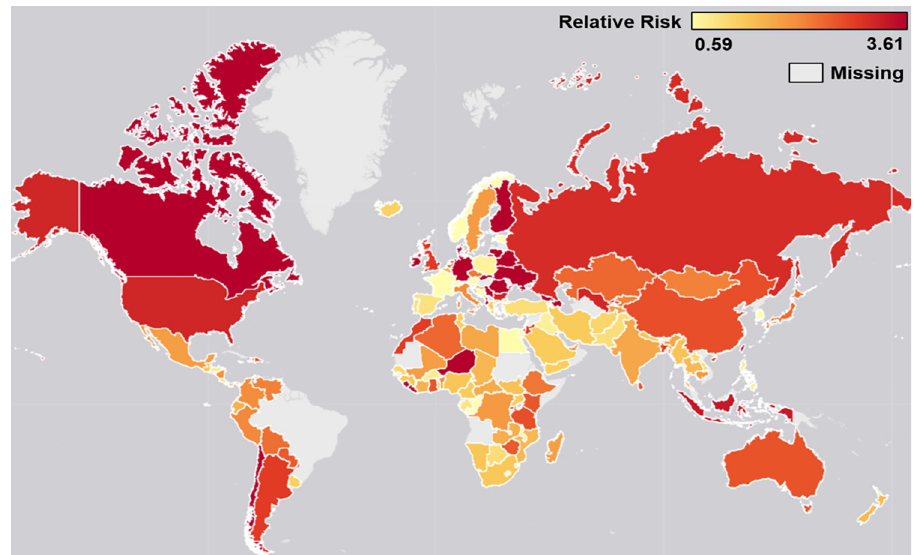
Fig 2. Heat map depicting the strength of association between food insecurity (Food Insecurity Experiences Scale) and poor mental health (Daily Experience Index score) in n = 137 countries. Notes: Presents relative risk estimates for moderate or severe FI vs. none or mild FI. Estimates were adjusted for gender, urbanicity, marital status, education, employment, number of children < 15 in household, age, and log annual household income (fixed effects). Five of the 142 countries in the Gallup World Poll sample were not included in the map (the regression models for Hungary, Latvia, North Macedonia, and Slovenia did not converge, Kosovo was not available in the map template). Base map available at: https://www.arcgis.com/home/item.html?id=ee8678f599f64ec0a8ffbfd5c429c896 [53]. https://doi.org/10.1371/journal.pgph.0000560.g002 Text) and model fit did not improve according to the likelihood ratio test. Fig 3 (left) provides a graphical representation of the interaction, showing that while poor mental health increased with greater FI, this effect did not differ by level of disaster severity.